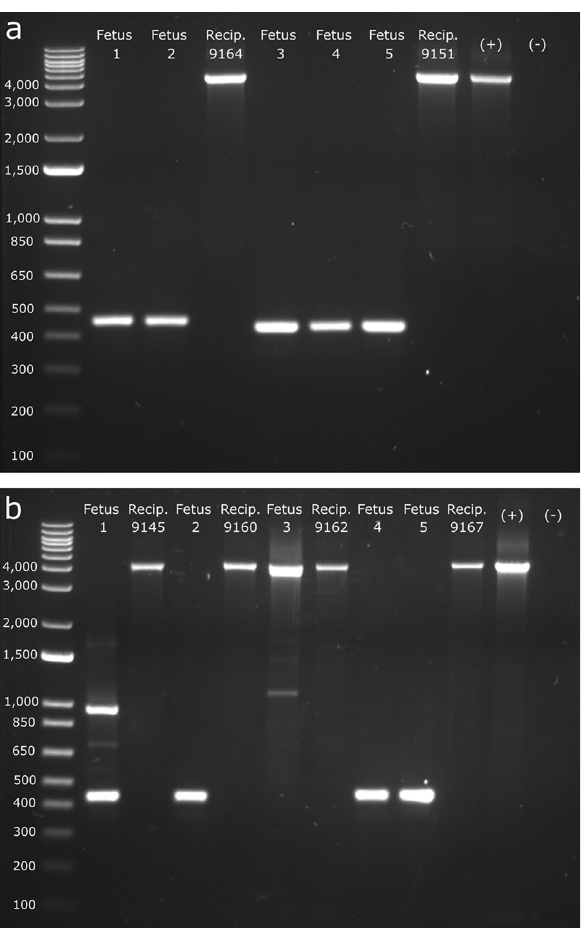
Figure 3. Fetal genotypic analysis from embryo transfers (ETs) and their corresponding recipients (recip.). Gels visualizing the genotypes of fetuses from ( a ) ET1 and ( b ) ET2. DNA was extracted from fetal and recipient tissue and PCR amplified. Gel electrophoresis was done to visualize the lincRNA#1 targeted deletion. lincRNA#1 amplicon is 4189 bp and expected knockout size is 456 bp. Recipient DNA follows the respective fetuses they